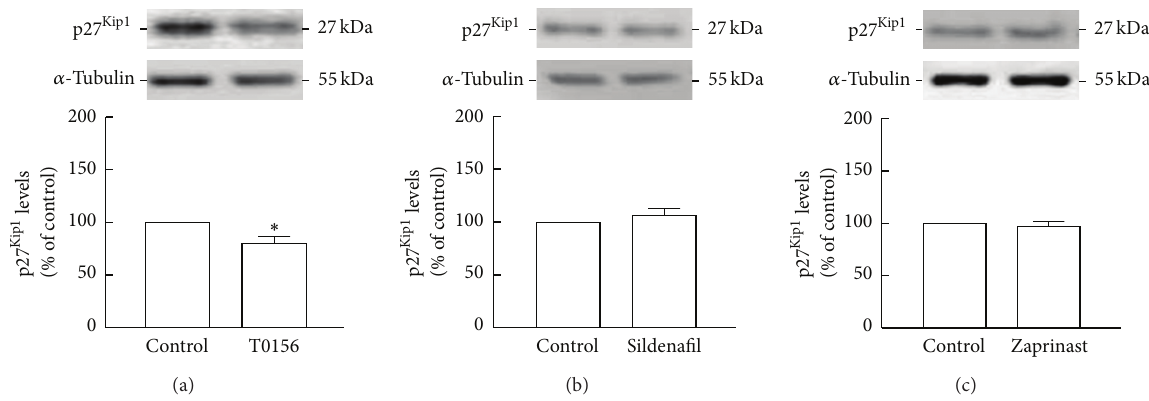
Figure 7: Treatment with T0156 decreased p2 7 Kip 1 levels. p2 7 Kip 1 levels following treatment 1 𝜇 M T0156 (a), 1 𝜇 M sildenafil (b), or 10 𝜇 M zaprinast (c) for 2 h were assessed by Western blot. Representative images are shown. Data are expressed as means ± SEM of at least 6 independent experiments. Two-tailed 𝑡 -test, ∗ 𝑃 < 0.05 , significantly different from control.